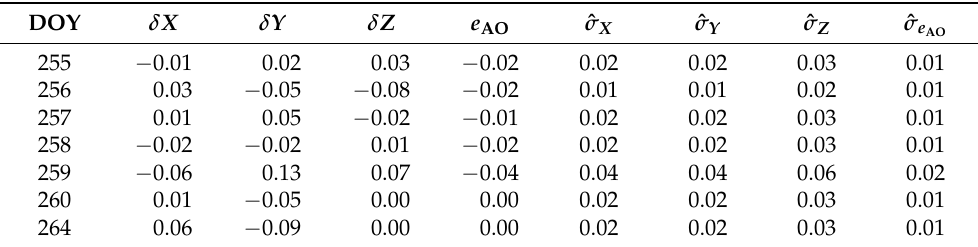
Table 3. Variations of the estimated reference point position P IRP , the derived axis offset e AO , and the related standard deviations. All estimates are given in